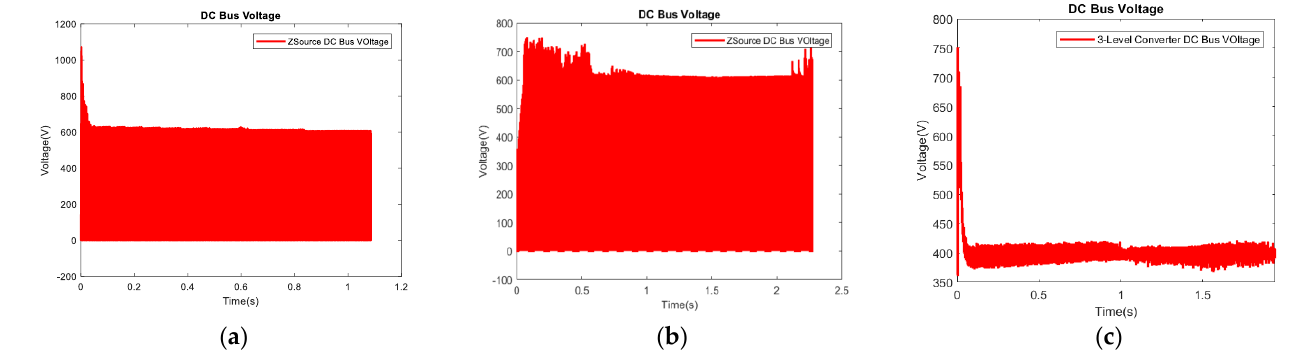
Figure 17. Voltage of the DC bus for ( a ) open-loop control BqZSI, ( b ) closed-loop control BqZSI, and ( c ) 3-level/SVPWM topology.